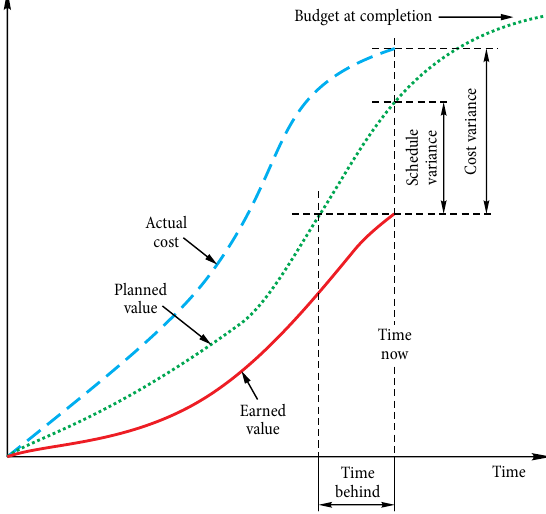
Fig. 1. Earned value graph – AC, EV and PV curves (Roseke 2015)